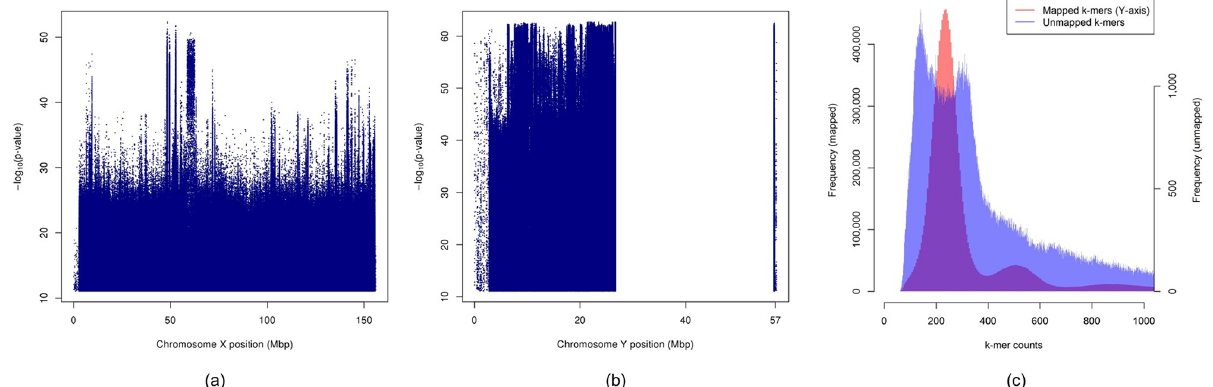
Fig 6. Manhattan plots showing negative logarithm of p-values of (a) k-mers positively correlated with female samples against their positions in Chromosome X, and (b) k-mers positively correlated with male samples against their positions in Chromosome Y. The region in Chromosome Y, where no k-mer mapped to, is missing from the reference genome i.e. represented by a sequence of Ns in the reference. (c) Histograms of counts of k- mers positively correlated with male samples that were mapped to Chromosome Y and those which could not be mapped.